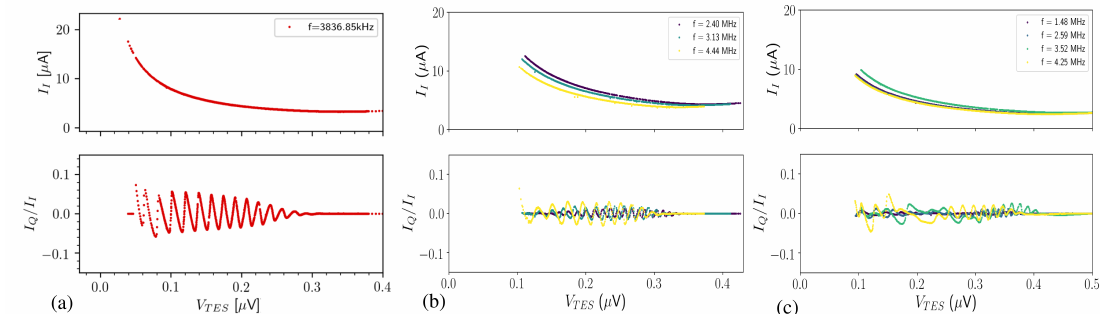
Figure 11. TES I–V curves for different X-ray microcalorimeter types and MHz bias frequencies. In the lower graph of each plot the ratio I Q / I I of the quadrature or Josephson ( I Q ) and in-phase I I current is shown. The data are from the following devices: ( a ) NASA-GSFC Mo/Au 75 × 17.5 µ m 2 (AR = 4:1, R N = 120m Ω ), ac biased at 3.8 MHz, ( b ) SRON Ti/Au 80 × 20 µ m 2 (AR = 4:1, R N (cid:39) 100m Ω ) [22], ac biased at 2.4–4.4 MHz and ( c ) SRON Ti/Au 80 × 10 µ m 2 (AR = 8:1, R N (cid:39) 200m Ω , ac biased at 1.4–4 MHz)